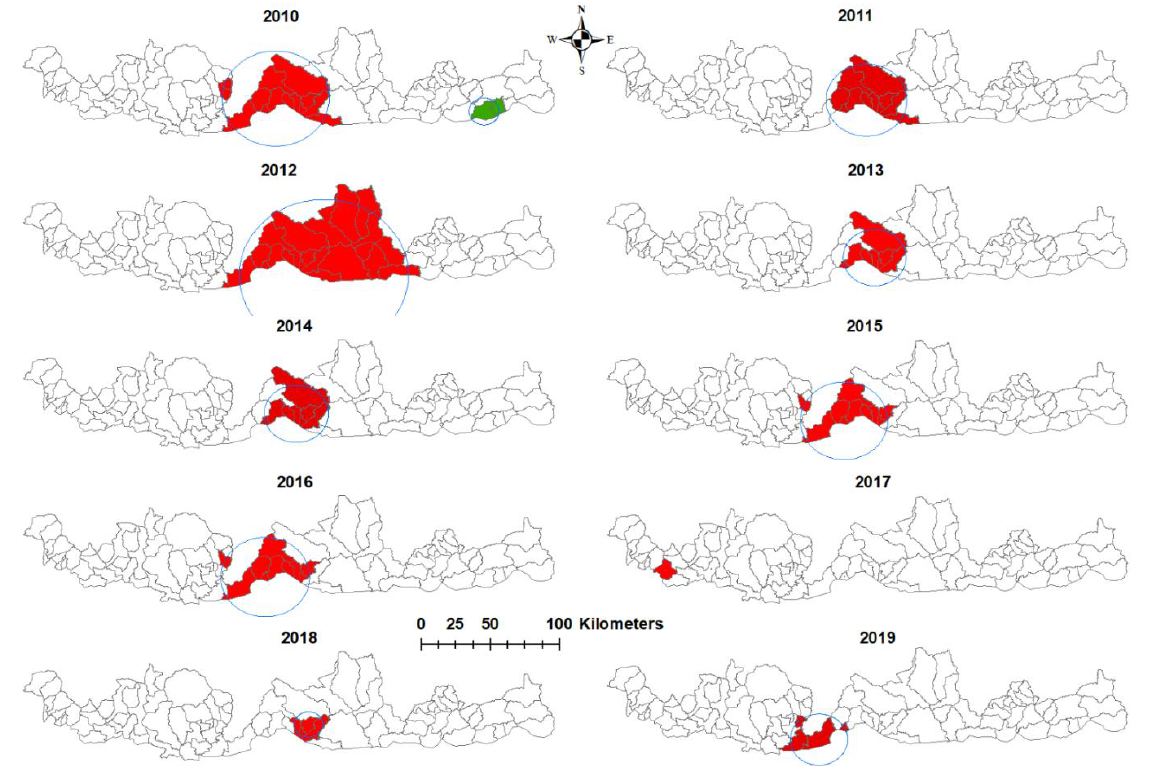
Table 3. Spatial clusters of Plasmodium vivax at sub-district level in Bhutan, 2006 – 2019.